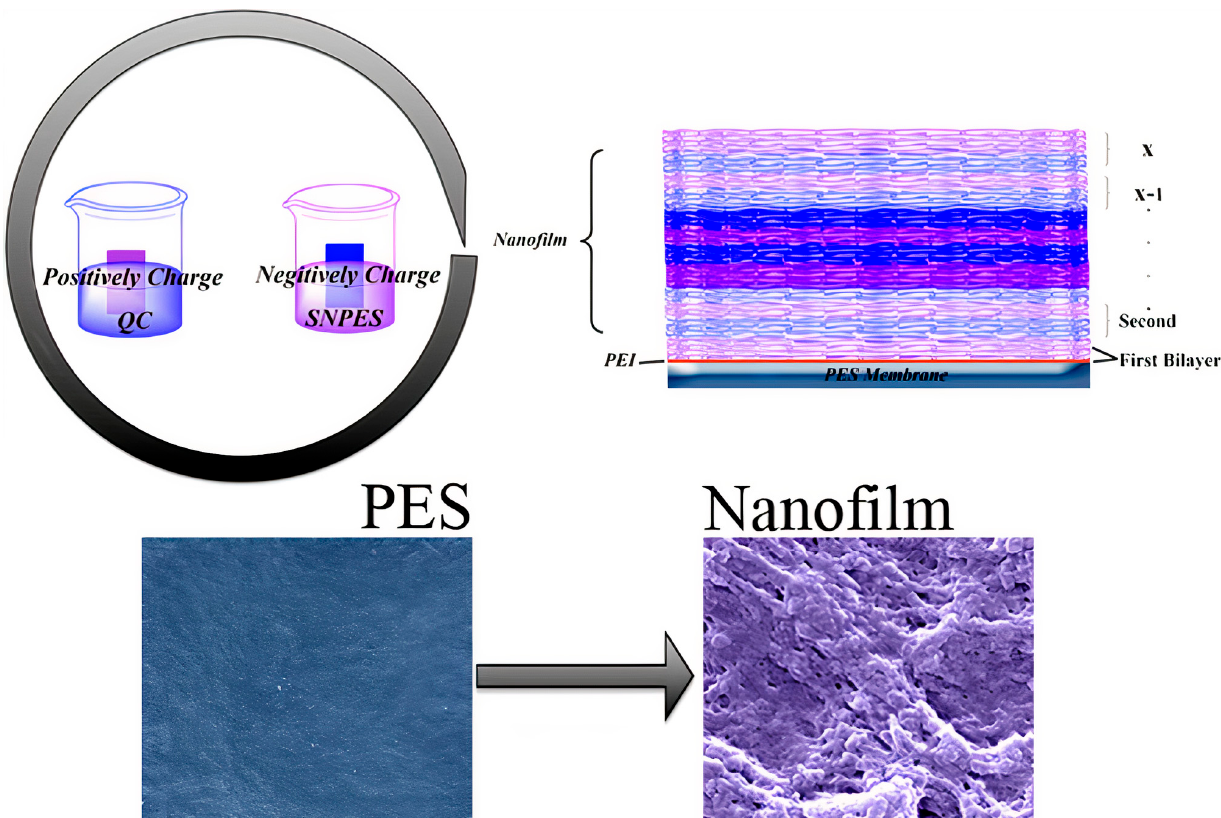
Figure 10. Scheme of layer − by − layer assembly of sulfonic amino poly (ether sulfone) (SNPES), a heparin − mimetic polymer, and quaternized chitosan (QC), an antimicrobial polymer, onto poly (ether sulfone) (PES) membrane substrates. SNPES and QC are negatively and positively charged, respectively. Reproduced with permission from [166]. Copyright 2015 American Chemical Society.